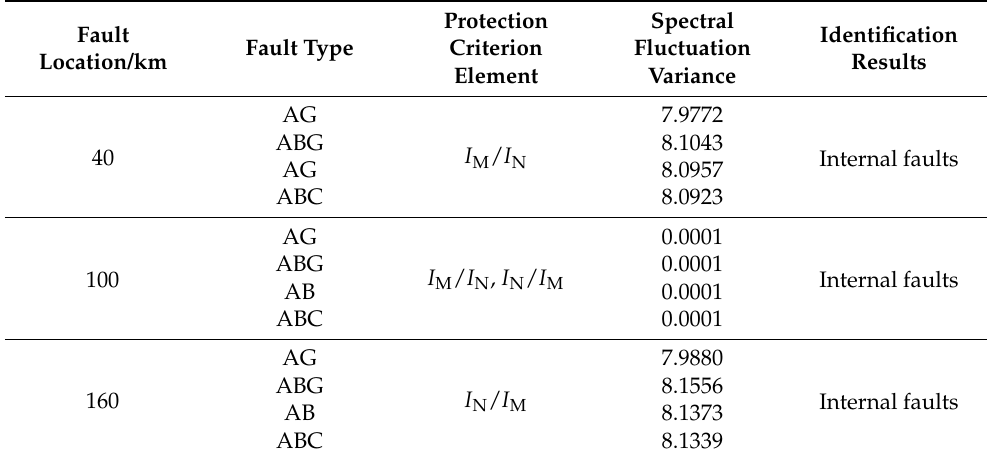
Table 3. Spectrum fluctuation variance in fault current ratios when different types of internal faults occur.